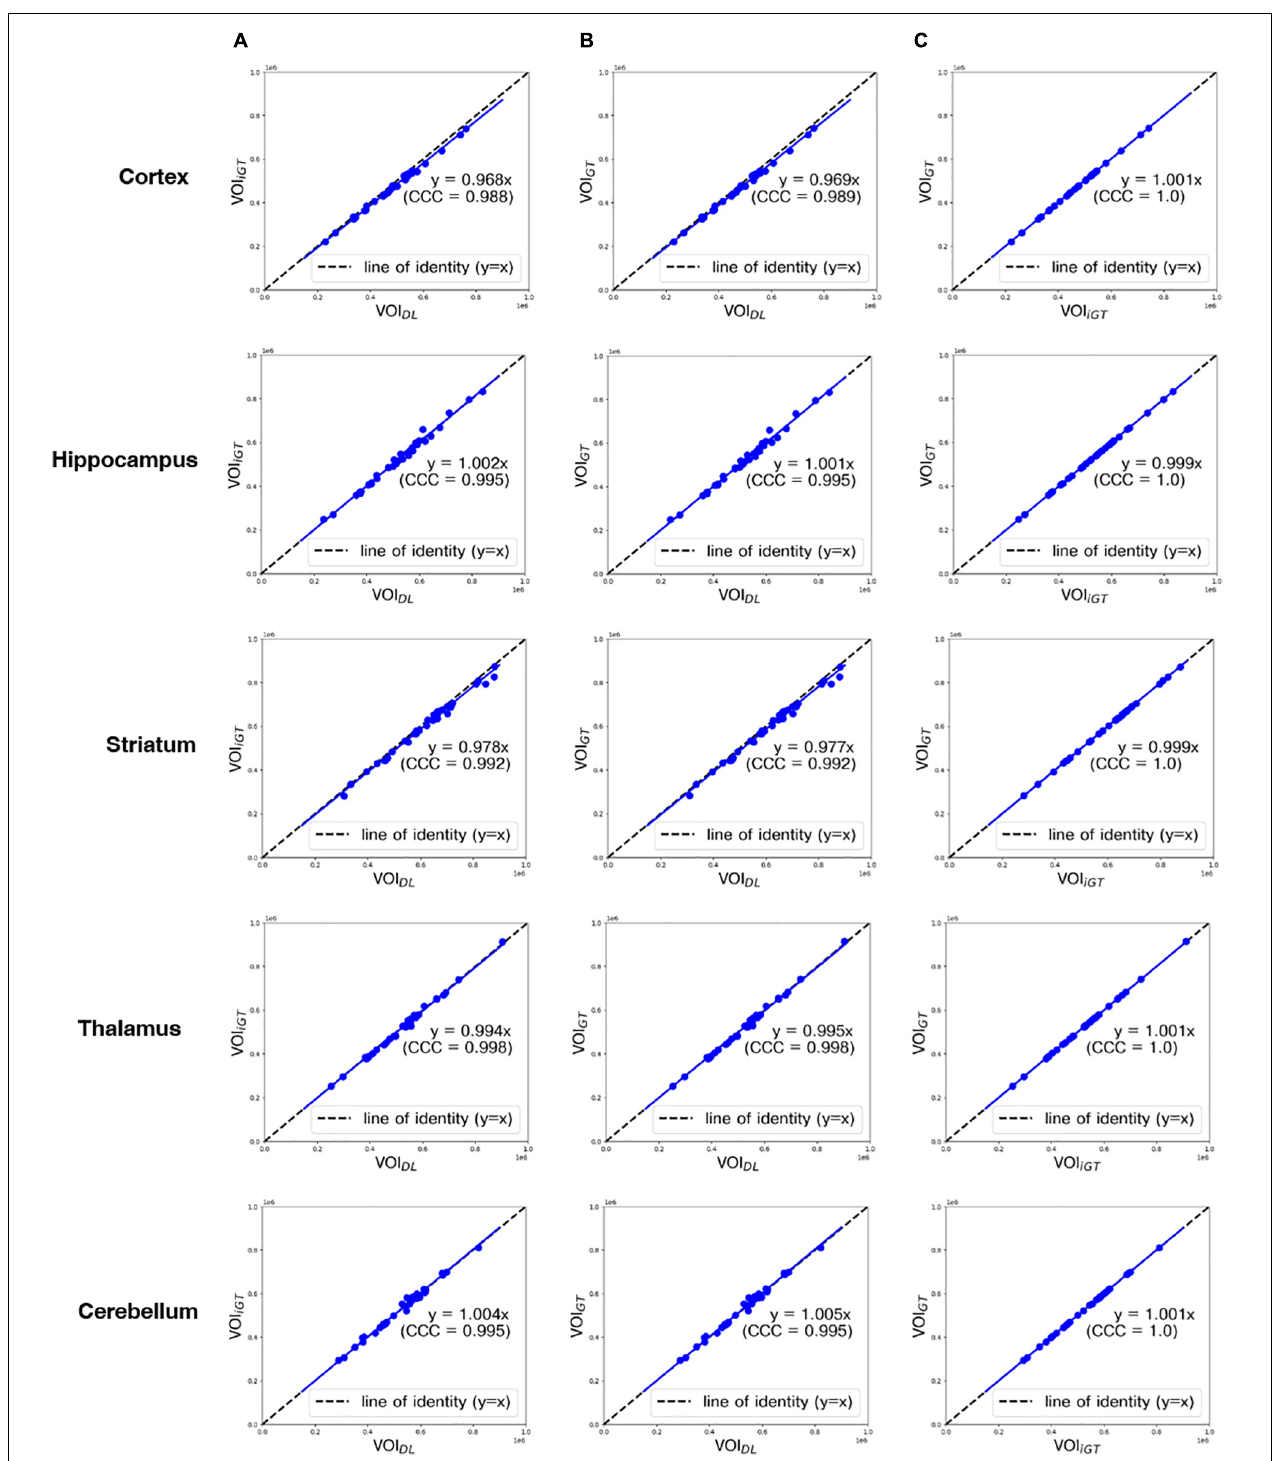
FIGURE 4 | Correlation analysis between all mean counts (blue dot) obtained using VOI DL , VOI iGT , and VOI GT in all target VOIs from the first to the fifth row (cortex, hippocampus, striatum, thalamus, and cerebellum, respectively). CCC represents a measure of reliability based on covariation and correspondence. The line of identity (dashed line) is depicted as a reference line. Cortex, hippocampus, striatum, thalamus, and cerebellum are represented sequentially from the top row. (A) Correlation analysis between each mean count obtained using VOI DL and VOI iGT . (B) Correlation analysis between each mean count obtained using VOI DL and VOI GT . (C) Correlation analysis between each mean count obtained using VOI iGT and VOI GT VOI DL , deep-learning generated-VOI; VOI iGT , deep learning (inverse-normalized ground-truth) label VOI; VOI GT , template-based ground-truth VOI; CCC, concordance correlation coefficient.